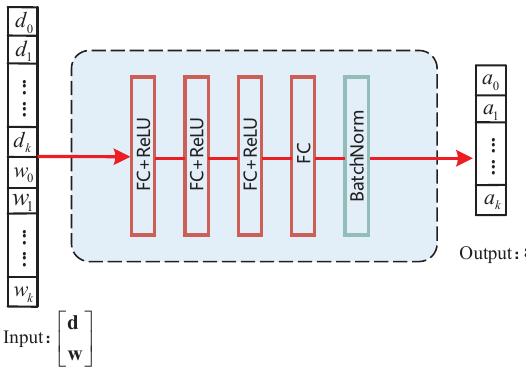
Figure 5. The process of the DSLO-DNN algorithm.